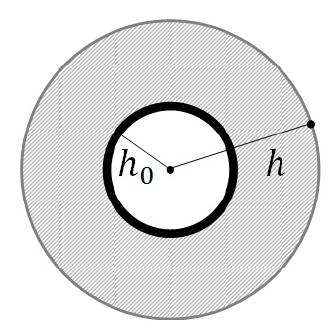
Figure 1. The perfectly conducting cylinder covered by the dielectric layer.